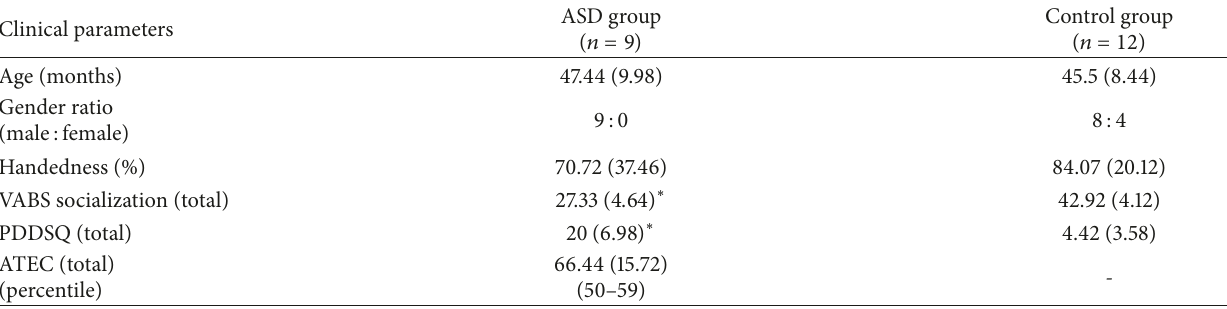
Table 1: The clinical characteristics of children in both the ASD and the control groups. Data is shown as mean and standard deviation (SD). Clinical parameters